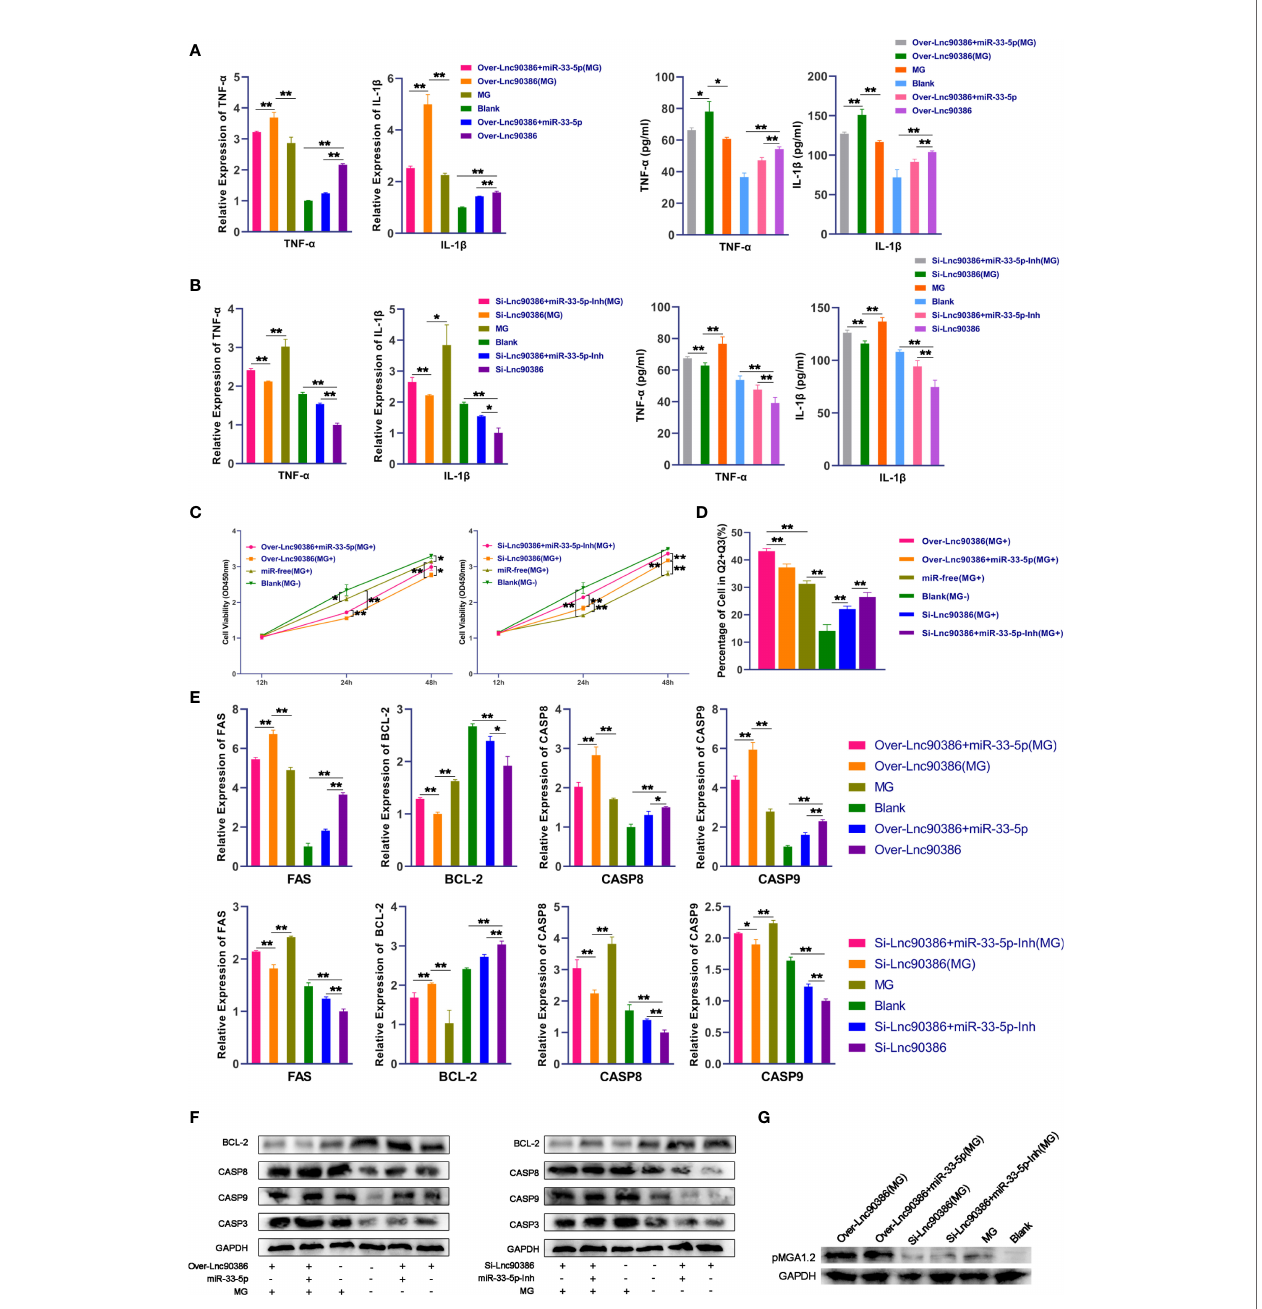
FIGURE 9 | Lnc90386 regulates MG infection through miR-33-5p/JNK1. DF-1 cells were transfected with oligonucleotides and infected with MG. (A) The expression levels of pro-in fl ammatory cytokines (TNF- a and IL-1 b ) after treatment with co-transfection of overexpression Lnc90386 vector and miR-33-5p mimics were detected by qPCR and Elisa; (B) The expression levels of pro-in fl ammatory cytokines (TNF- a and IL-1 b ) after treatment with co-transformation of Si-Lnc90386 and miR-33-5p inhibitor were detected by qPCR and Elisa; (C) CCK-8 kit was used to detect cell proliferation at 12, 24, 48h post-infection; (D) The cells were stained with Annexin V- PI and analyzed by fl ow cytometer after 24h post-infection; (E) The relative mRNA expression level of apoptosis marker genes after treatment with co-transfection of overexpression Lnc90386 vector and miR-33-5p mimics or co-transformation of Si-Lnc90386 and miR-33-5p inhibitor was detected by qPCR; (F) The protein expression of apoptosis marker genes treatment with co-transfection of overexpression Lnc90386 vector and miR-33-5p mimics or co-transformation of Si- Lnc90386 and miR-33-5p inhibitor was detected by Western blot and qPCR; (G) Western blot was used to detect the adhesion protein pMGA1.2 of MG treatment with co-transfection of overexpression Lnc90386 vector and miR-33-5p mimics or co-transformation of Si-Lnc90386 and miR-33-5p inhibitor. GAPDH was used as the internal control. Data was expressed as the mean ± SD of three independent experiments, each with three replicates. (* p < 0.05, ** p <